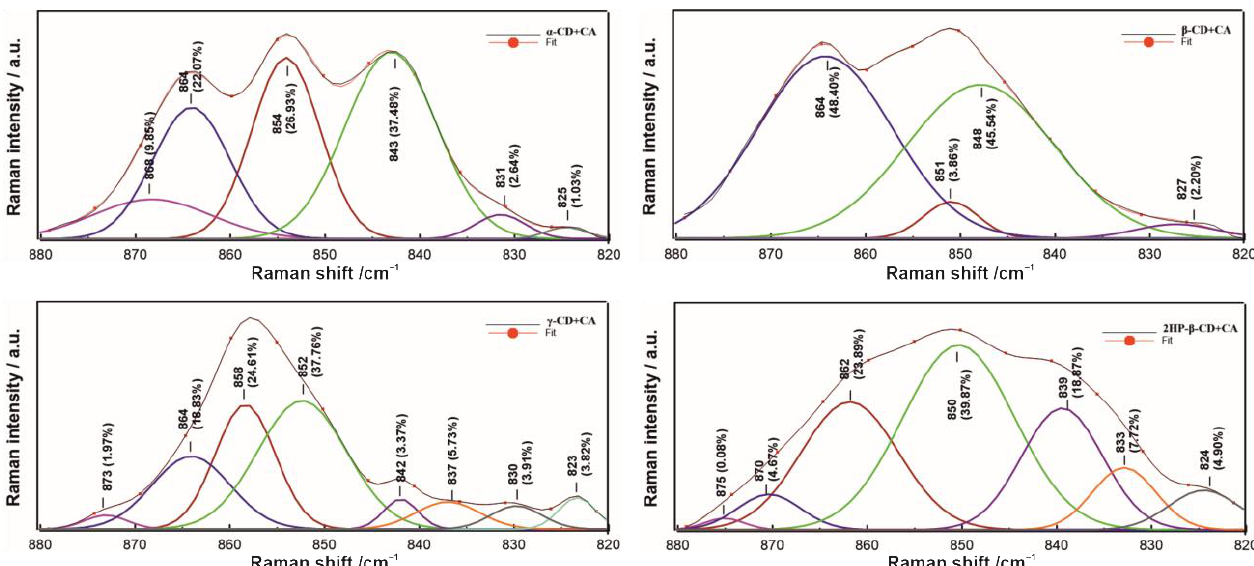
Figure 8. Deconvolution of 880–820 cm −1 band into particular sub-bands using mixed Lorentzian/Gaussian curve fitting. Each sub-band has marked a maximum value and a percentage share of its entire band surface area.